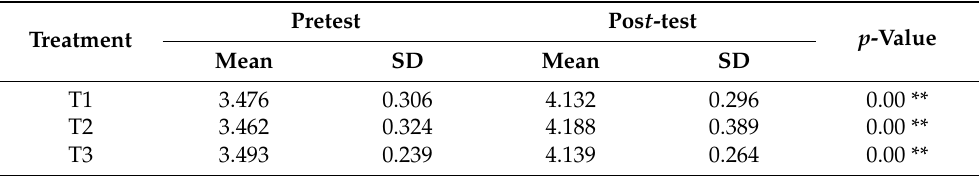
Table 4. The t -test scores on the effects of knowledge. Treatment